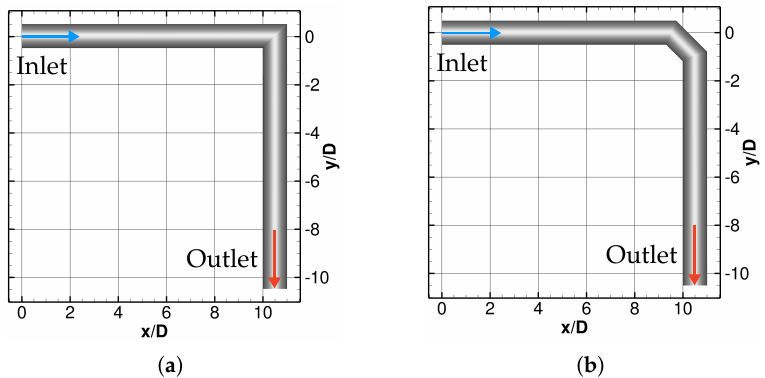
Figure 5. Geometries of the investigated pipe bend configurations. ( a ) 90 ◦ pipe bend. ( b ) 45 ◦ pipe